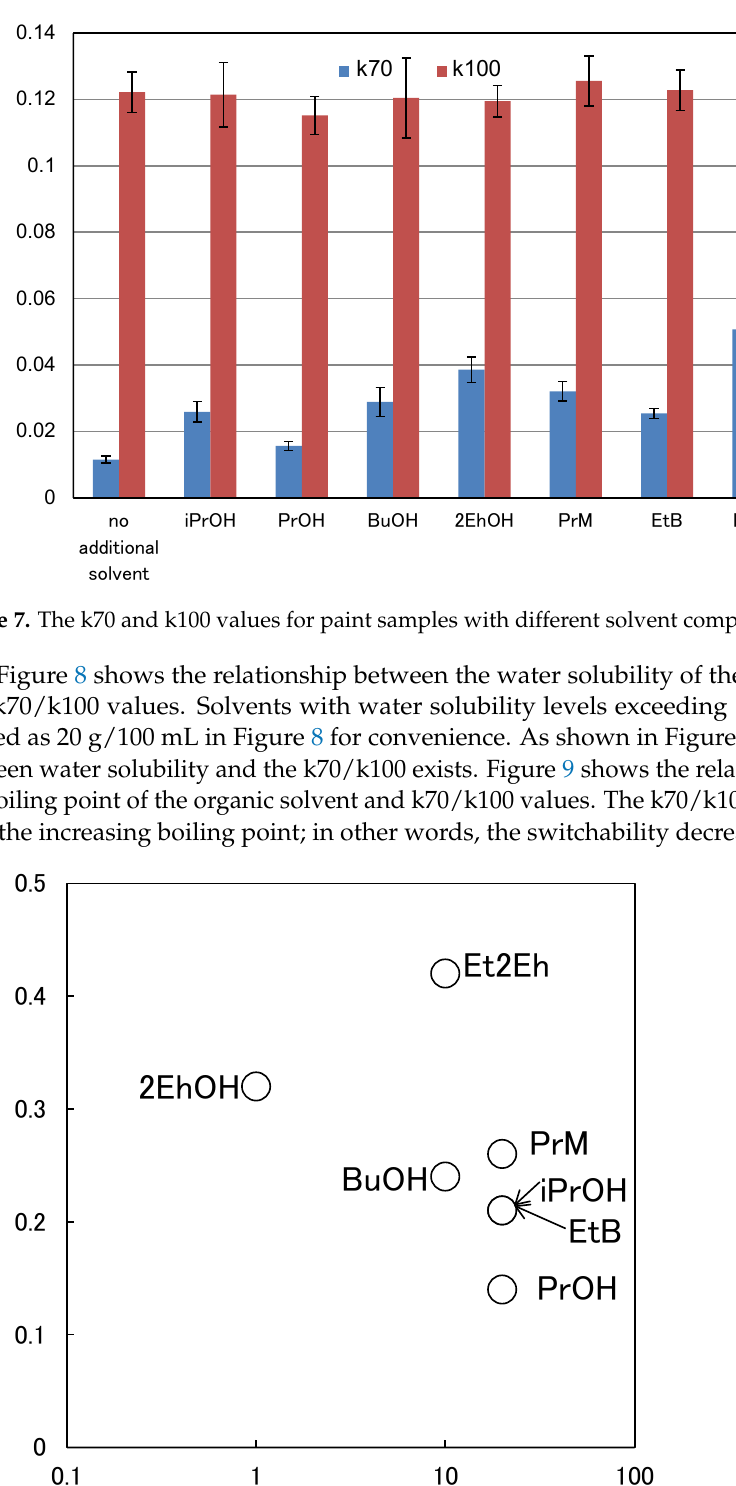
Figure 8. Relationship between water solubility at 20 °C and k70/k100 values.